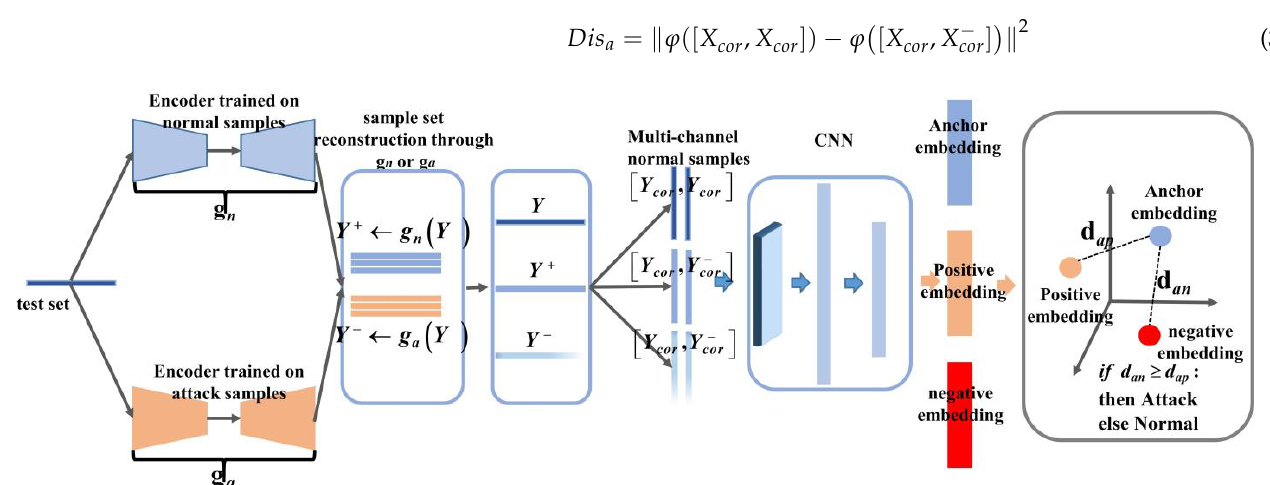
Figure 2. MCLDM prediction stage.